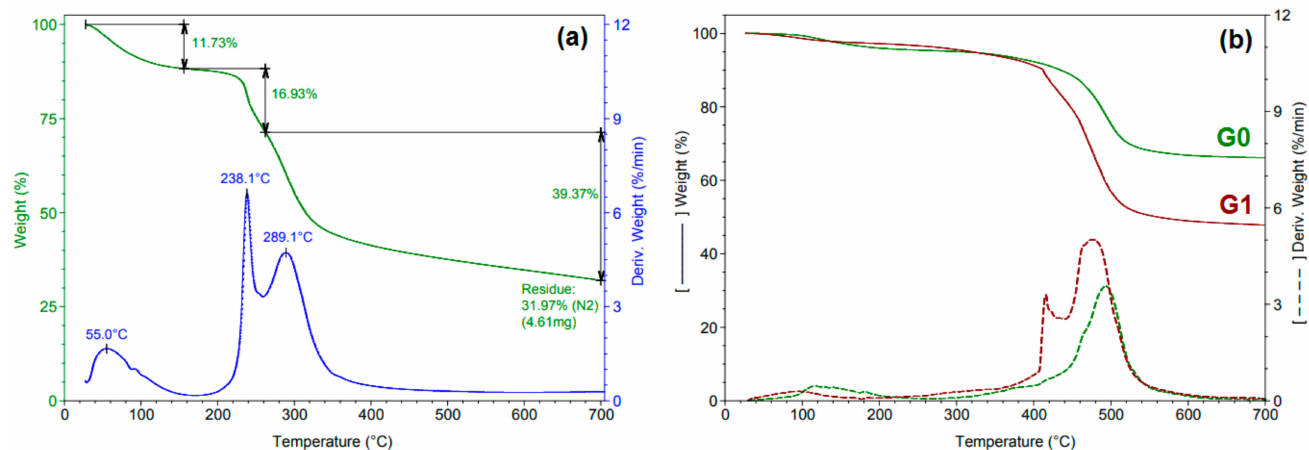
Figure 2. Thermogravimetric analysis curves of: ( a ) gentamicin sulfate (GS), ( b ) SiO 2 NPs (sample G0) and silica-gentamicin nanostructured solution (sample G1), obtained as powders.